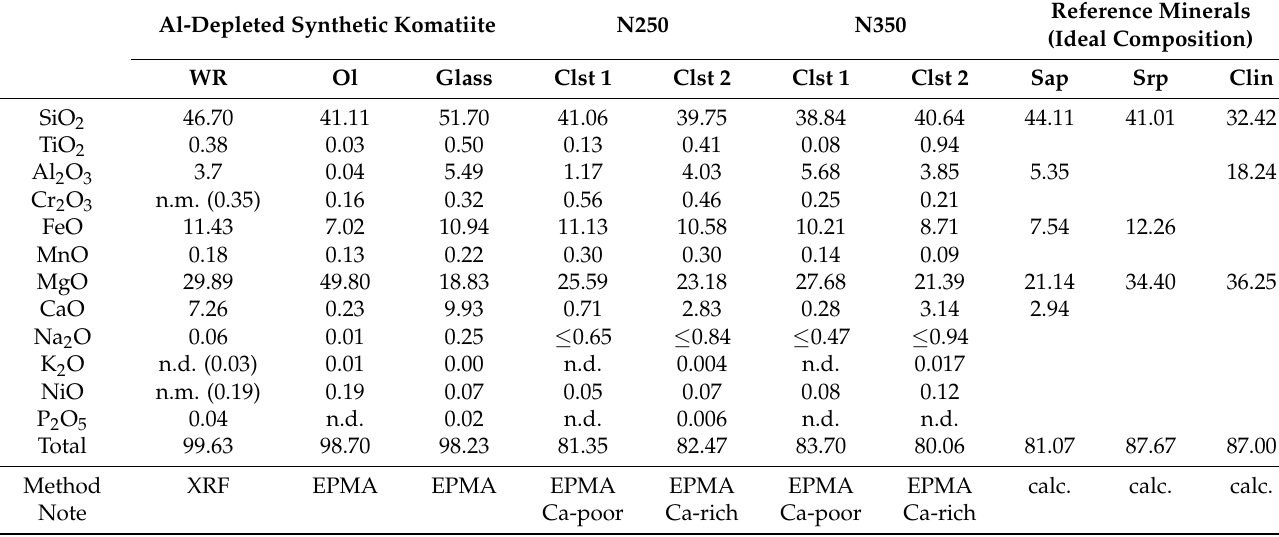
Table 4. Composition of synthetic komatiite and solid reaction products from the experiments in the komatiite–H 2 O–NO 3 − system at 250 ◦ C and 350 ◦ C (values in wt.%).